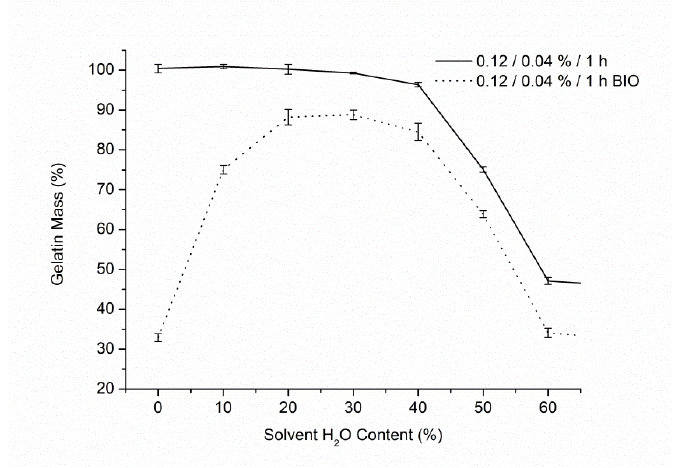
Figure 3. Gelatin content of the samples right after crosslinking with EDC/NHS and after biodegradation test vs. water content in the solvent.